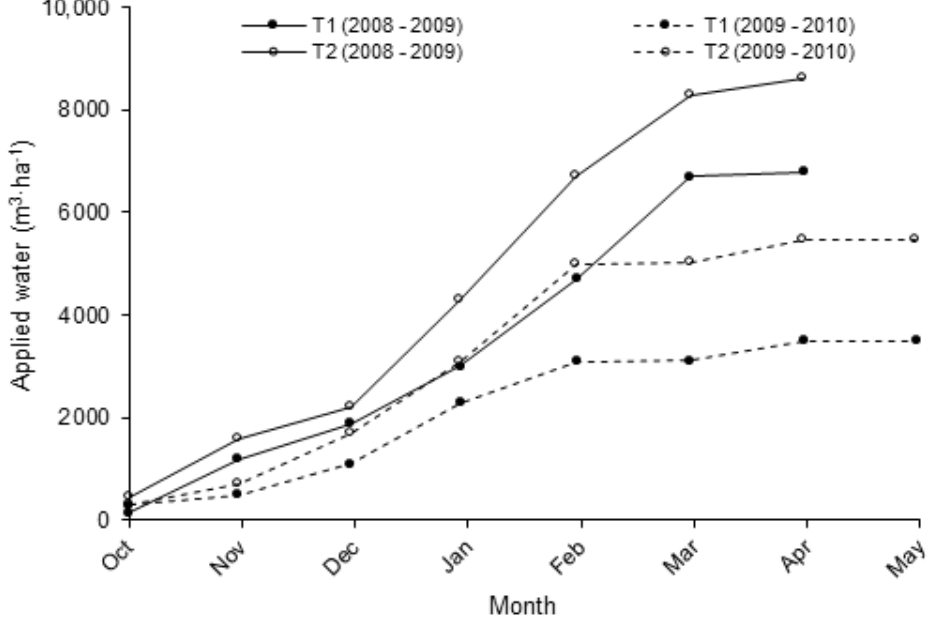
Figure 4. Cumulative applied water during the 2008–2009 and 2009–2010 irrigation seasons in two water application treatments via drip irrigation of ‘Brookfield Gala’ apple trees. T1: Irrigation with theoretical volume required by plant. T2: Irrigation with farm protocol.